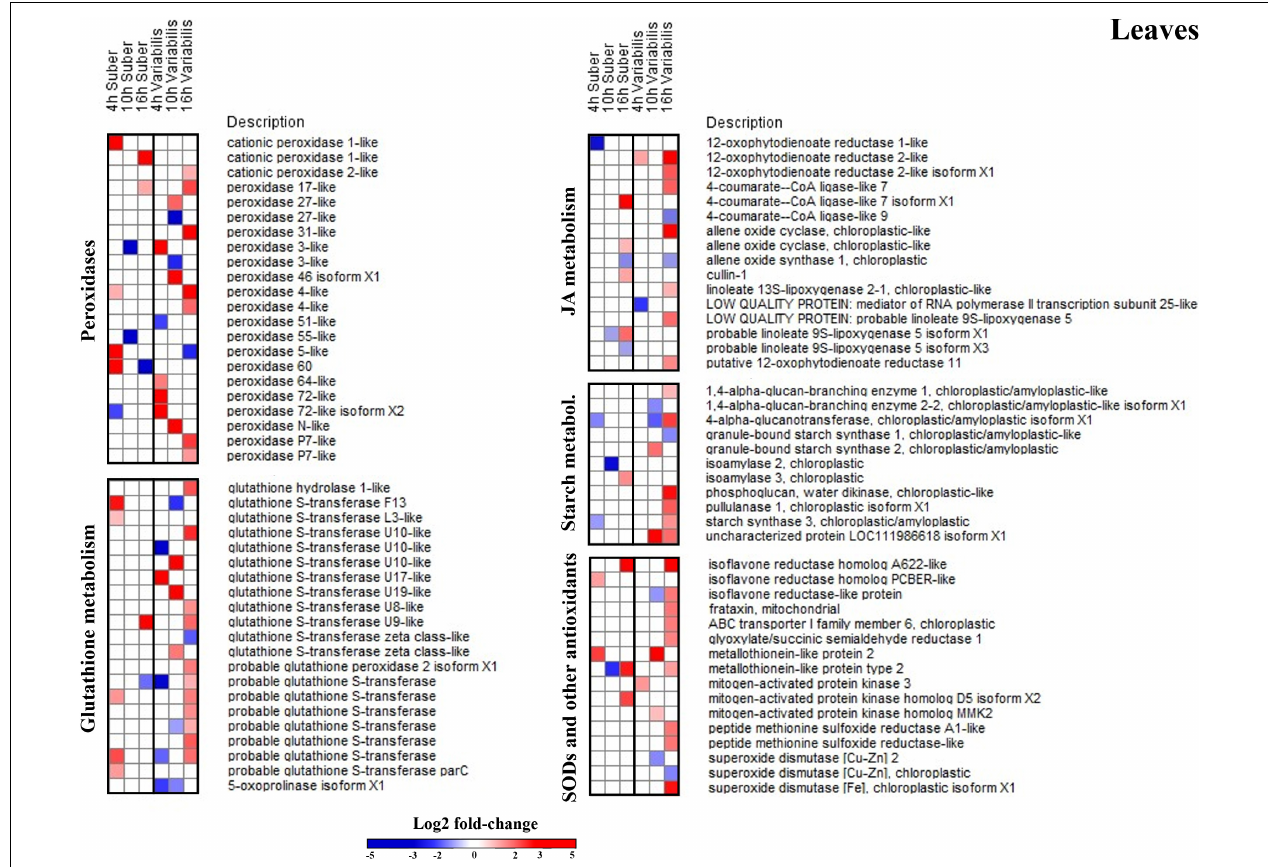
FIGURE 5 | Log2-fold changes (|FC| ≥ 2, p < 0.05) in the abundance of leaf proteins related to several relevant biological processes in Q. suber and Q. variabilis 4, 10, and 16 h after inoculation with P. cinnamomi